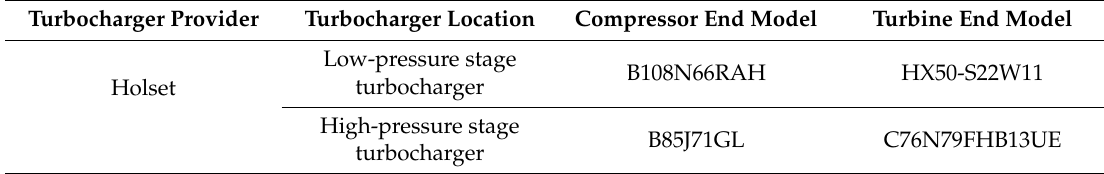
Table 5. Model selection of the two-stage